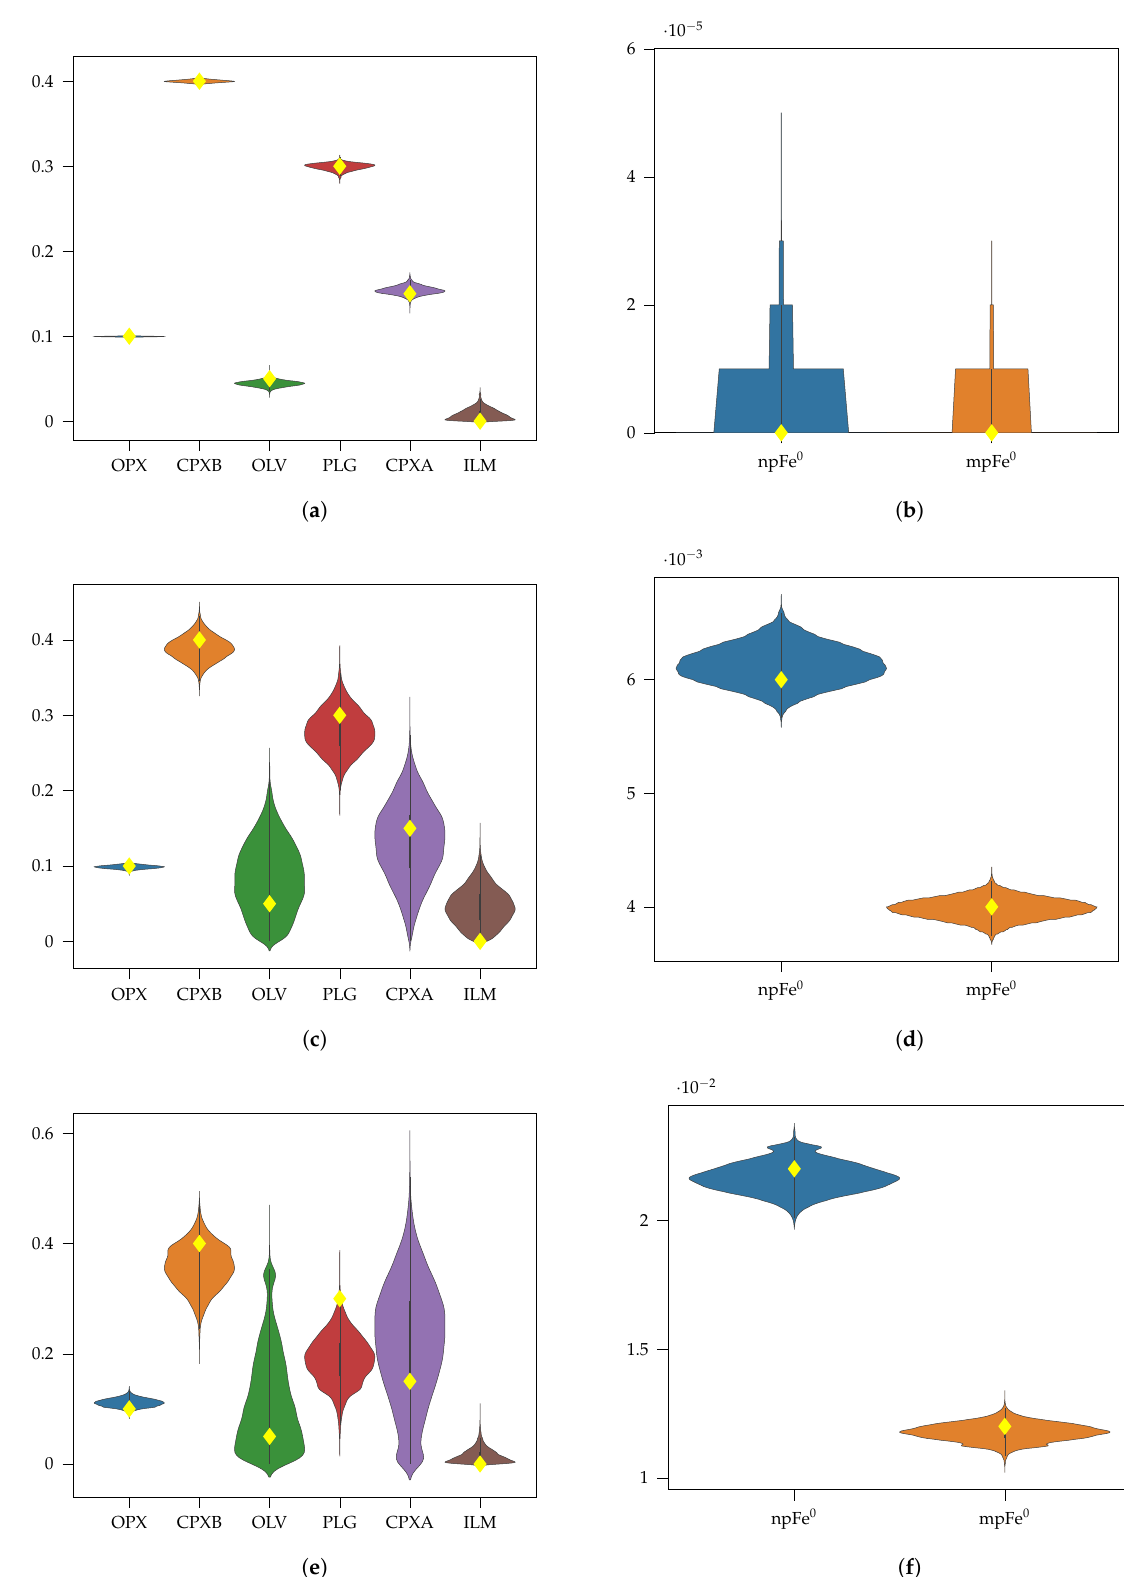
Figure 7. Violin plots for synthetic mixtures 0, 5, and 15 for the MCMC sampling without a prior on the elemental abundances. These mixtures do not contain ilmenite, but the posterior distribution contains many solutions with significant amounts of ilmenite. Yellow diamonds mark the true abundances that were used for mixing the endmembers. ( a ) Without elemental prior (mix 0 ); ( b ) Without elemental prior (mix 0 ); ( c ) Without elemental prior (mix 5 ); ( d ) Without elemental prior (mix 5 ); ( e ) Without elemental prior (mix 15 ); ( f ) Without elemental prior (mix 15